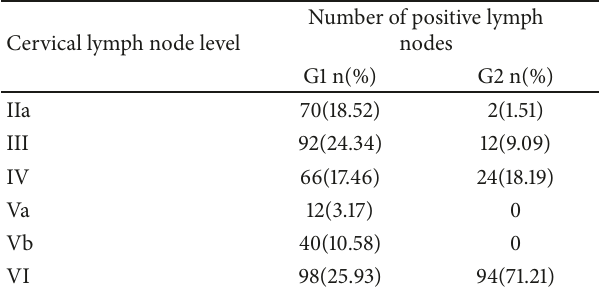
Table 1: Distribution and percentage of positive